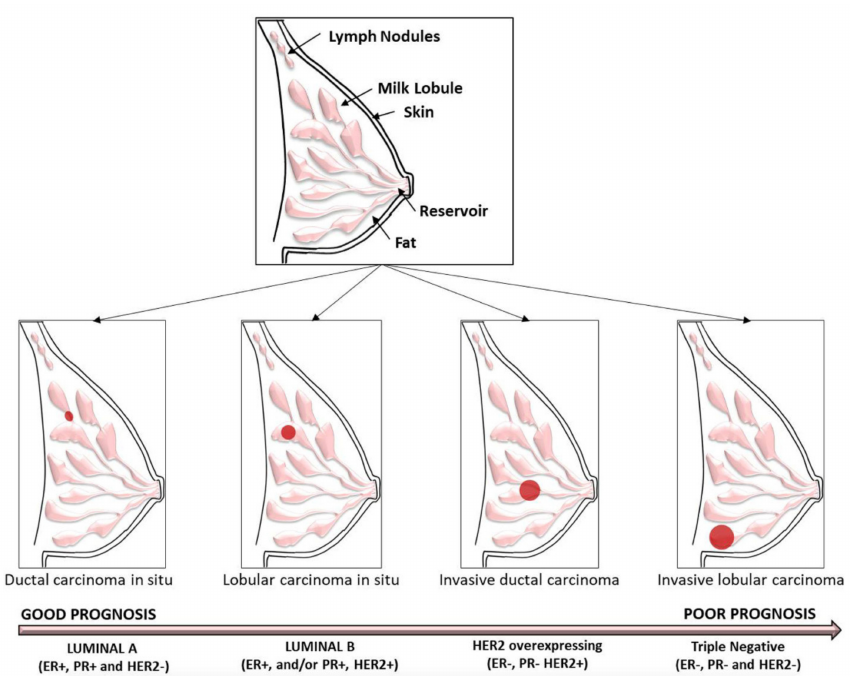
Figure 1. Drawings representing histological and molecular BC subtypes with corresponding prog- nostic implications (ER: Estrogen Receptor; PR: Progesterone Receptor; HER2: Human epidermal growth factor receptor 2). The red dots indicate the cancer